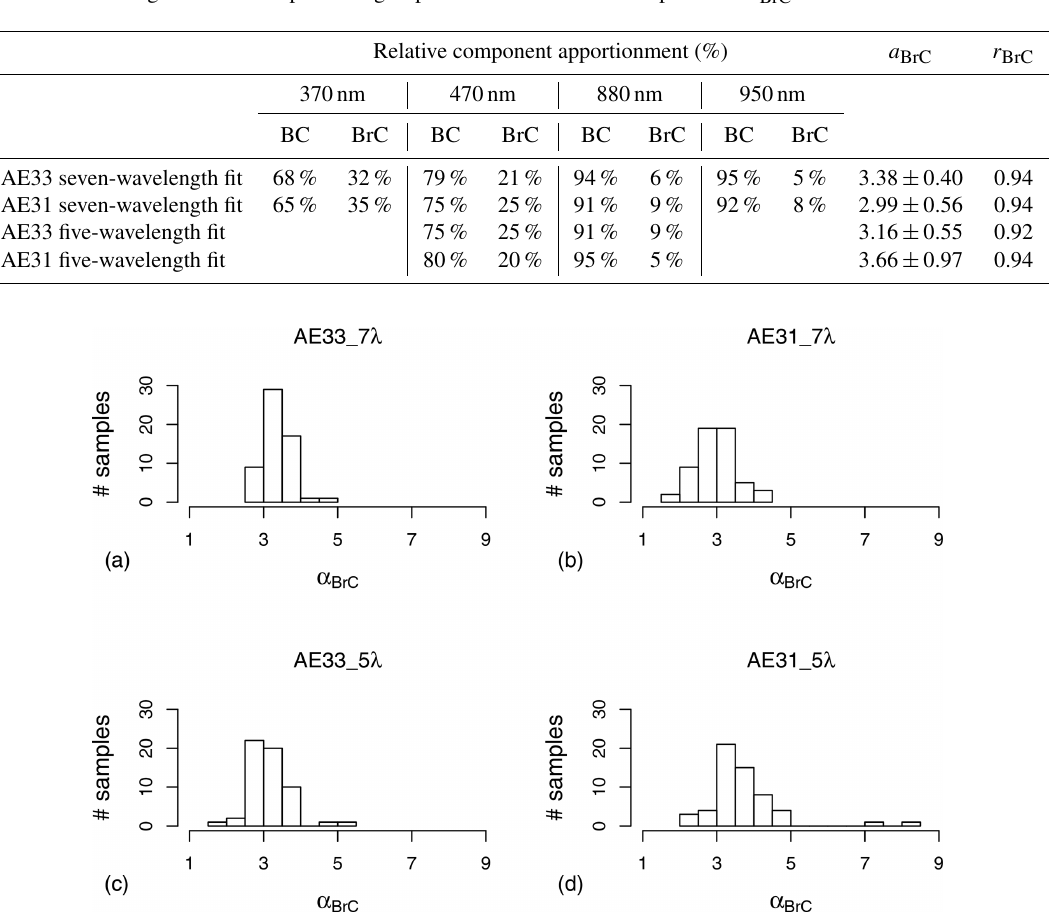
Table 6. Absorption coefficient relative component apportionment using the Aethalometer model fixing α BC as 1. The model was applied to AE31 and AE33 data using different data processing as presented in Sect. 2.7. The presented r BrC refers to 470nm in all cases.